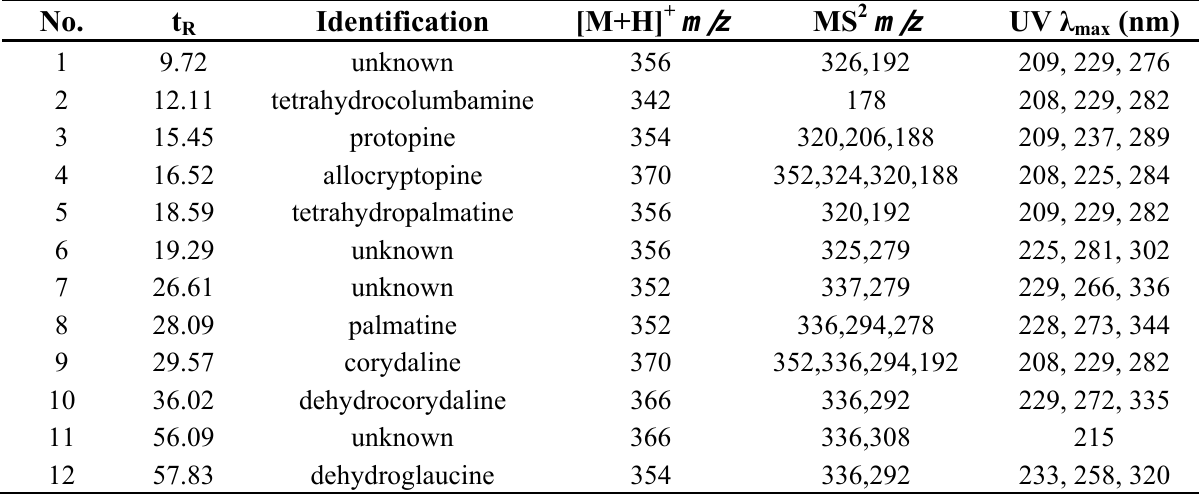
Table 1. Peak assignments for analysis of the dichloromethane extract of C. yanhusuo